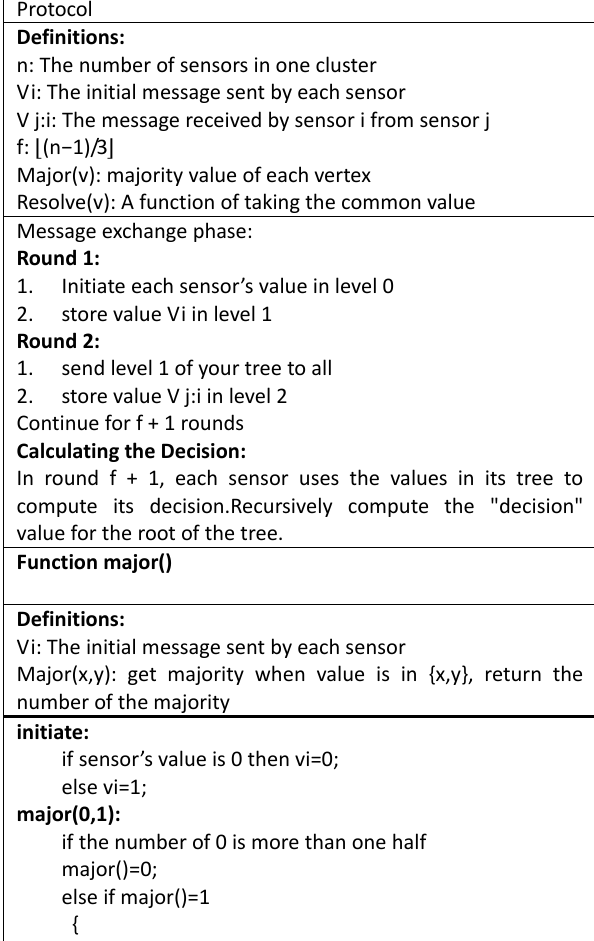
Fig.1. M-TREE for